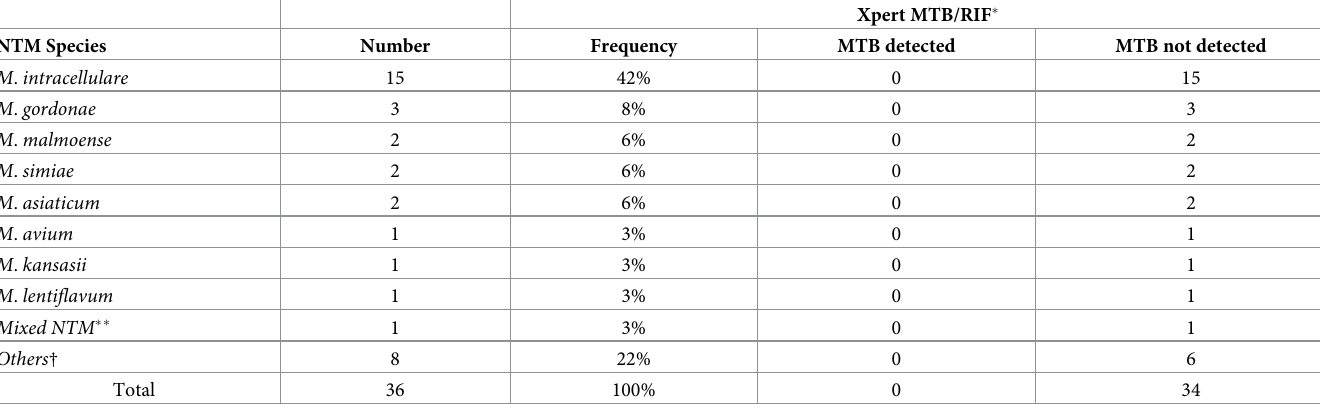
Table 2. NTM isolated among PLHIV presenting with TB symptoms who received anti-TB treatment in Botswana and corresponding Xpert MTB/RIF